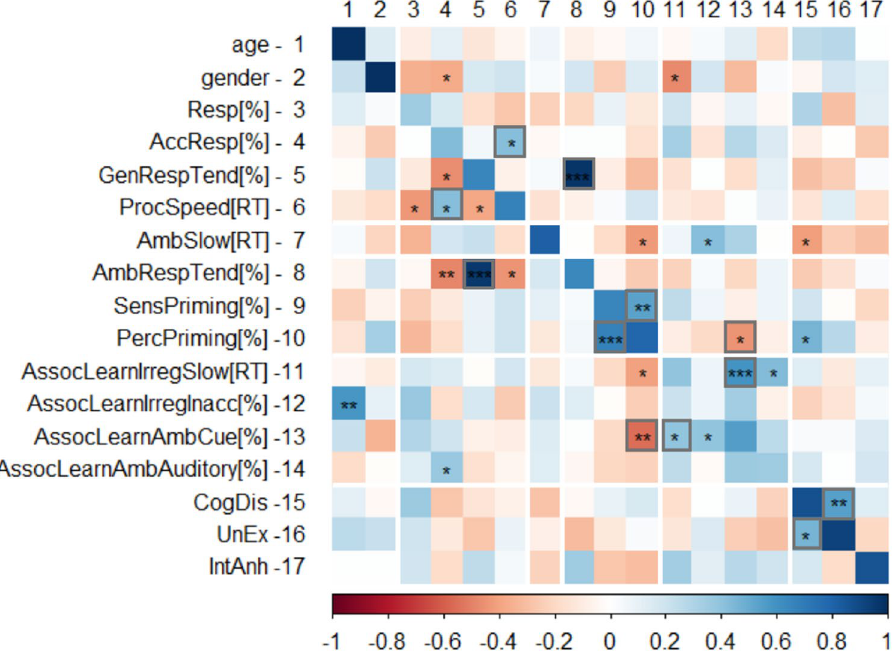
Figure 3. Correlations between task performance, schizotypal traits and demographics. Spearman’s rank order correlation of each variable. Lower triangle: session 1, upper triangle: session 2, diagonal: test–retest. Significance levels: *: p < 0.05, **: p < 0.01, ***: p < 0.001. Grey rectangles indicate replicated significant correlations (both sessions). Variable labels: 1: age; 2: gender (higher [blue] = males score higher); 3: Resp[%]. Response rate (%); 4. AccResp[%]. Accurate responses under certainty (% of correct responses); 5. GenRespTend[%]. General response tendency (% of ‘left’ response); 6. ProcSpeed[RT]. General perceptual speed (RT to expected certain stimuli, ms); 7. AmbSlow[RT]. Perceptual inference speed under uncertainty (RT to unexpected minus expected, ms); 8. AmbRespTend[%]. Response tendency under uncertainty (% of ‘left’ response); 9. SensPriming[%]. Sensory priming effect under uncertainty (% consistent with perceptual decision on previous unambiguous trial); 10. PercPriming[%]. Perceptual decision priming effect under uncertainty (% consistent with perceptual decision on previous ambiguous trial); 11. AssocLearnIrregSlow[RT]. Associative learning effect under certainty—cost of irregularity (ms RT); 12. AssocLearnIrregInacc[%]. Associative learning effect under certainty—cost of irregularity (% accurate responses); 13. AssocLearnAmbCue[%]. Associative learning effect under uncertainty—cue-consistency (congruent cues); 14. AssocLearnAmbAuditory[%.] Associative learning effect under uncertainty—auditory dominance (incongruent cues); 15. CogDis. Cognitive disorganisation—O-Life subscale sum; 16. UnEx. Unusual experiences—O-Life subscale sum; IntAnh. Introvertive anhedonia—O-Life subscale